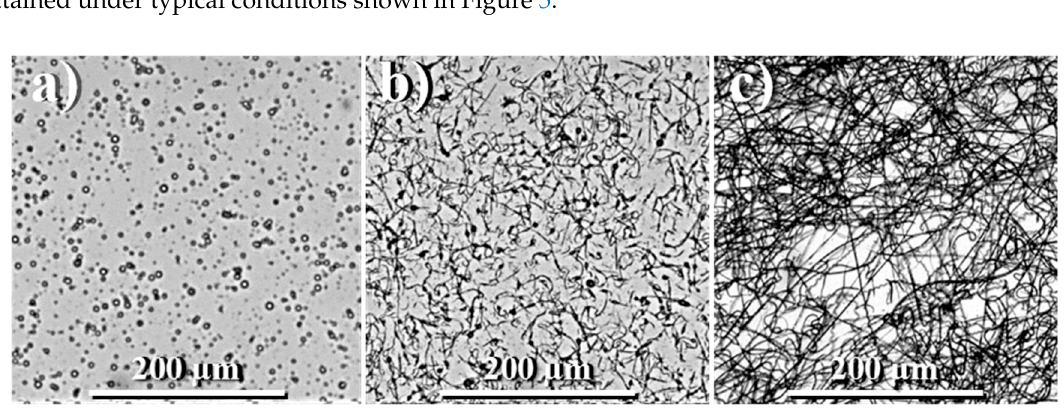
Figure 5. Optical micrographs showing typical electrospun morphologies attained from PEG concentrations of 37% ( a ), 47% ( b ) and 50% ( c ) in water.